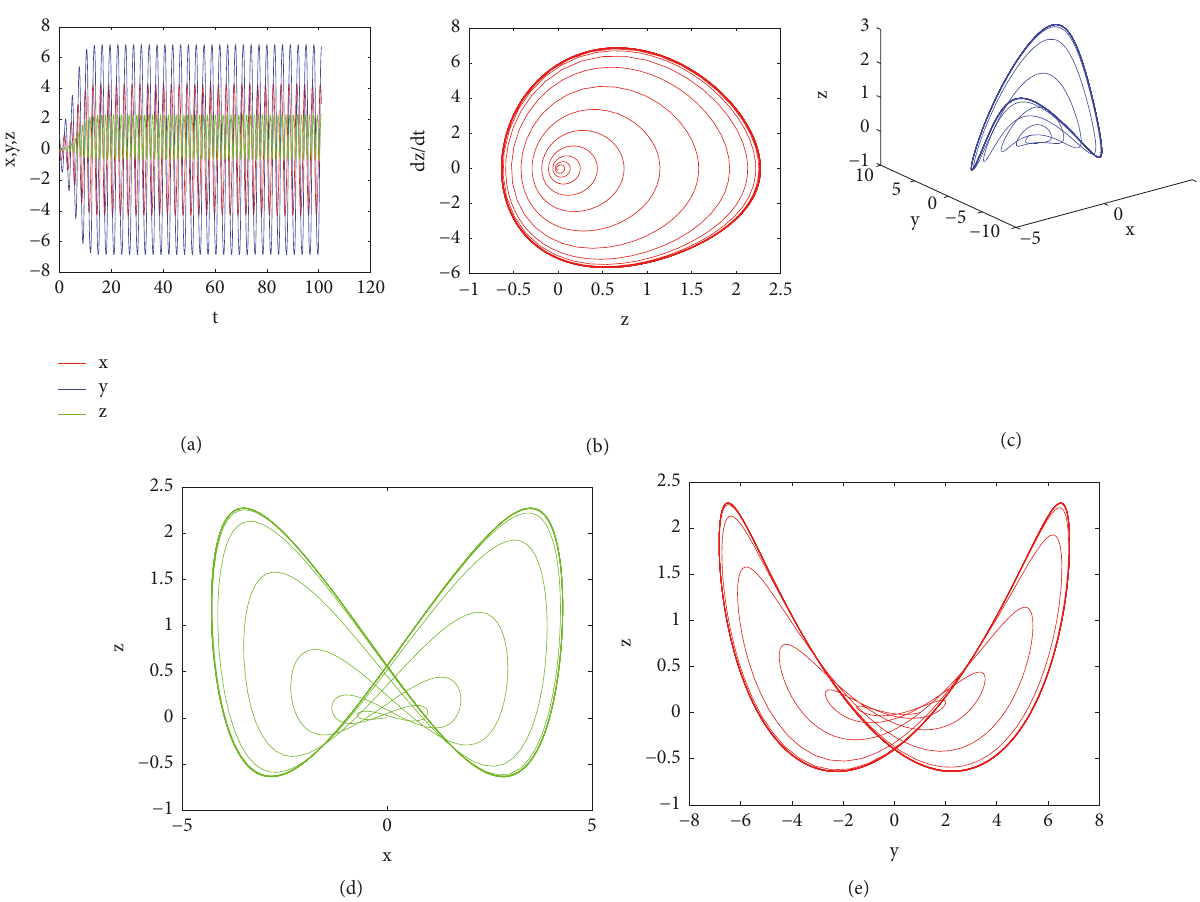
Figure 2: Lorenz system for Experiment 1 at 𝑐 = 10 : (a) time series plot; (b) phase diagram of 𝑧 ; (c) on the three-dimensional space; (d) projected on the (𝑥,𝑧) -plane; (e) projected on the (𝑦, 𝑧) -plane. projected on (𝑥, 𝑧) -plane; (c) is the graph projected on (𝑦, 𝑧) - plane. Figure 11 is time series plots of the 3D chaotic Lorenz type system for Experiment 3 at different parameter value 𝑐